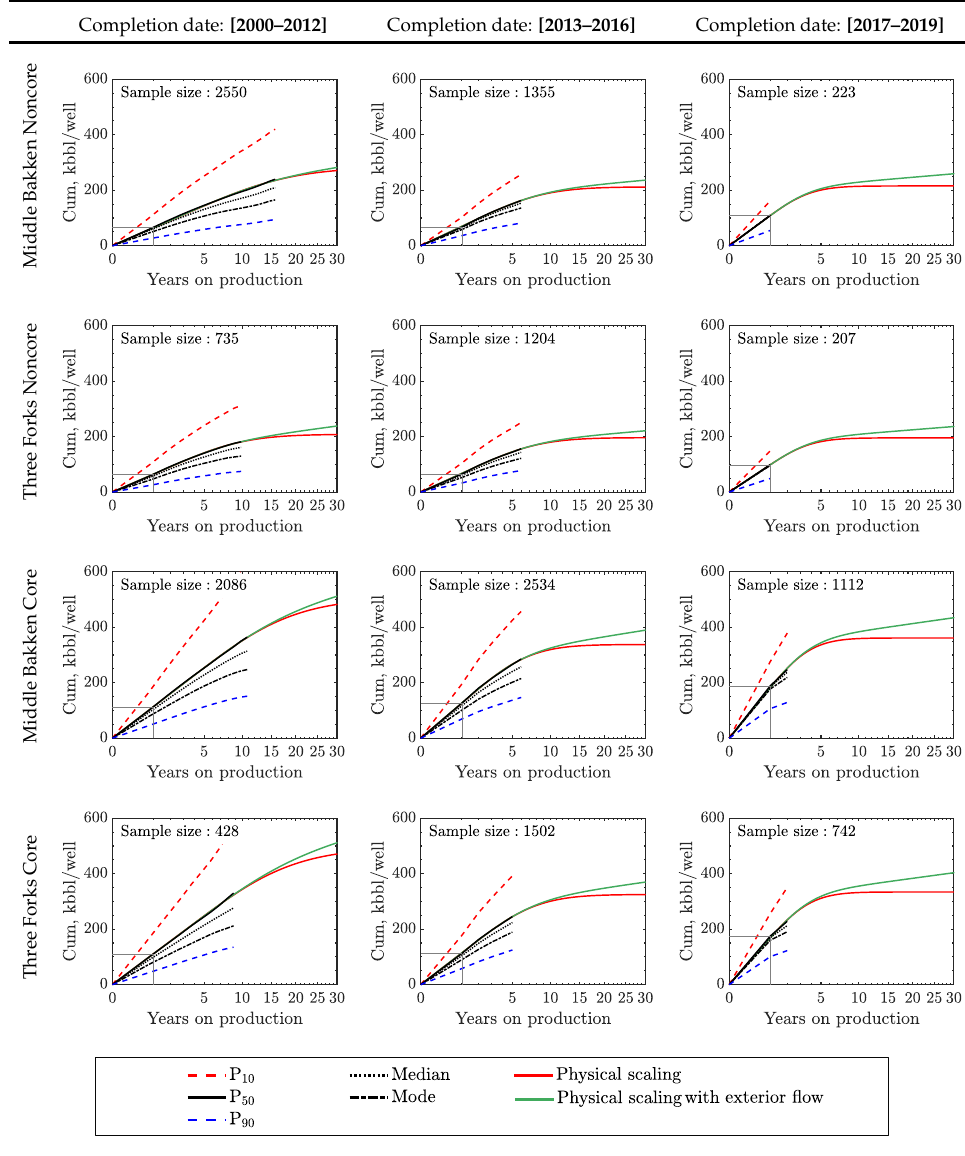
Figure 6. Average wells in 12 regions in the Middle Bakken and Three Forks. These wells are located in both the core and noncore areas and have three different completion periods, (2000–2012), (2013–2016) and (2017–2019). Each year in the past, every average well traces the expected values of the Generalized Extreme Value (GEV) distributions of all active horizontal wells in each well cohort, which have at least 1,2,...,15 years on production. The dashed lines labeled P 10 and P 90 denote wells whose cumulative production is exceeded by 10% and 90% of wells in each region. The red and green lines are the physics-based scaling curves that match each average well, respectively, with and without exterior flow during late time production. In general, ultimate oil recovery from the core areas is higher than that from the noncore ones. The Middle Bakken wells are slightly more productive than the Three Forks wells. The newly completed wells have much higher initial oil production, but they decline faster, resulting in more or less the same ultimate recovery as older wells.